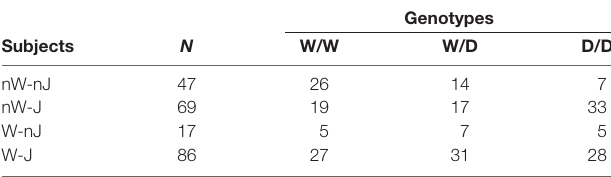
TABLE 1 | Distribution of the serotonin transporter (5-HTT) genotypes in chicks exhibiting walking and jumping behaviors in the avoidance test.